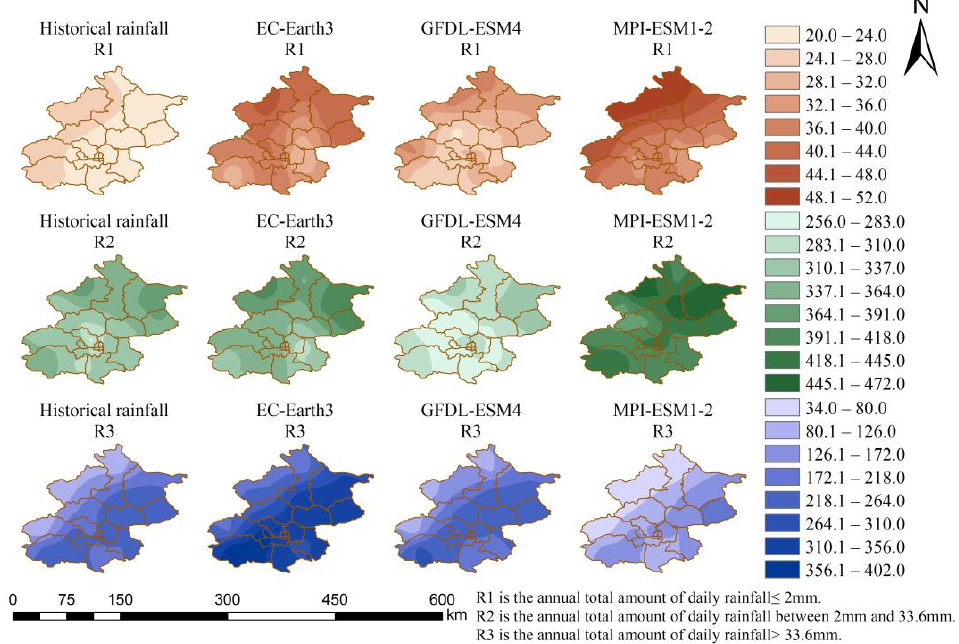
Figure 5. Spatial distribution of the annual total amount of each type of rainfall .